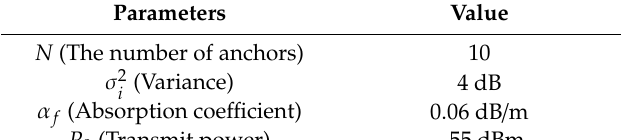
Table 7. Parameters in the scenario with variable Side Parameters